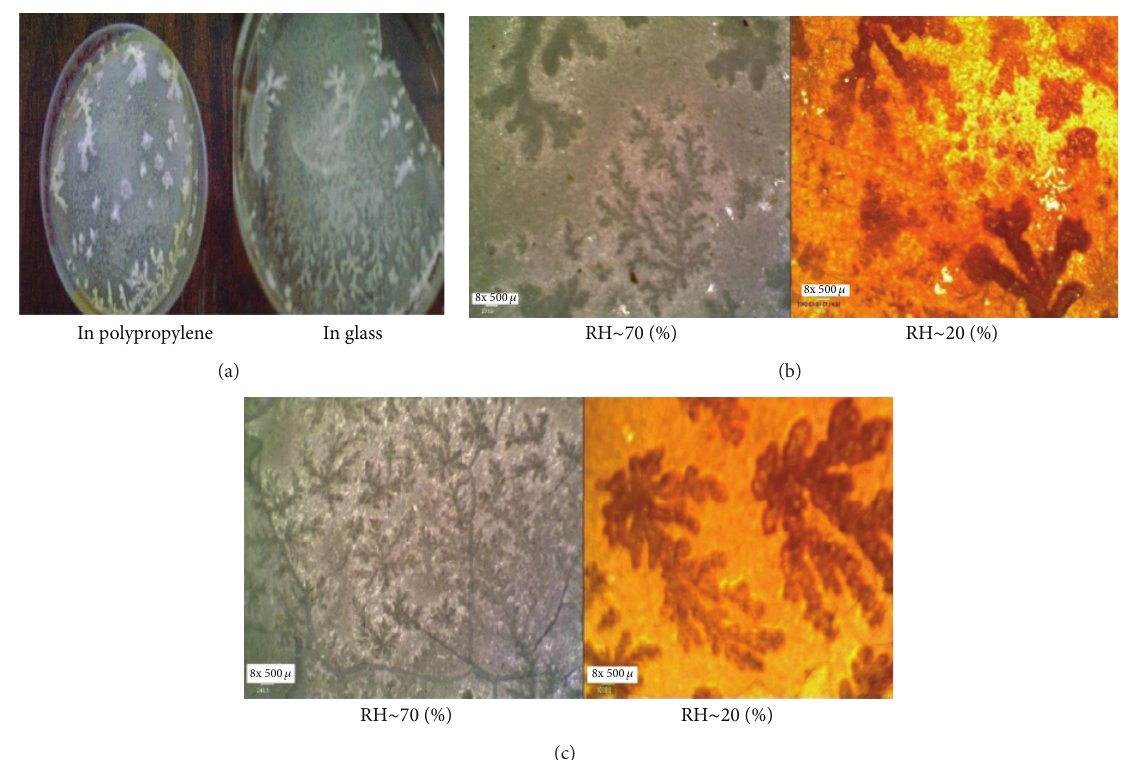
Figure 3: (a) Sample in polypropylene and glass Petri dishes. (b) Sample kept in different humidity levels in polypropylene Petri dish. (c) Sample kept in different humidity levels in glass Petri dish.